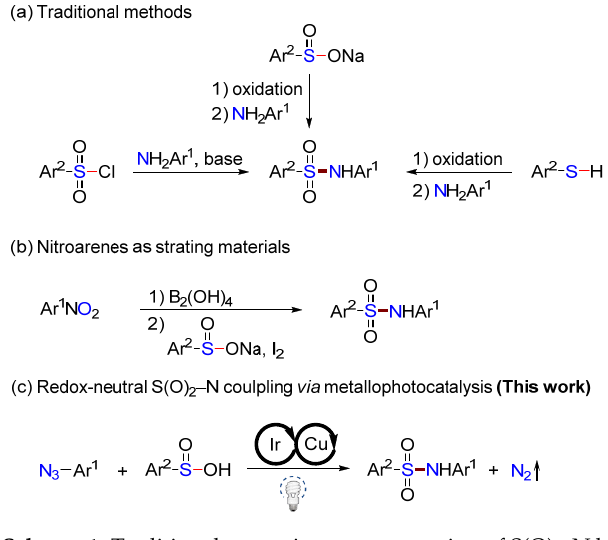
Figure 1. Selected examples of bioactive sulfonamide